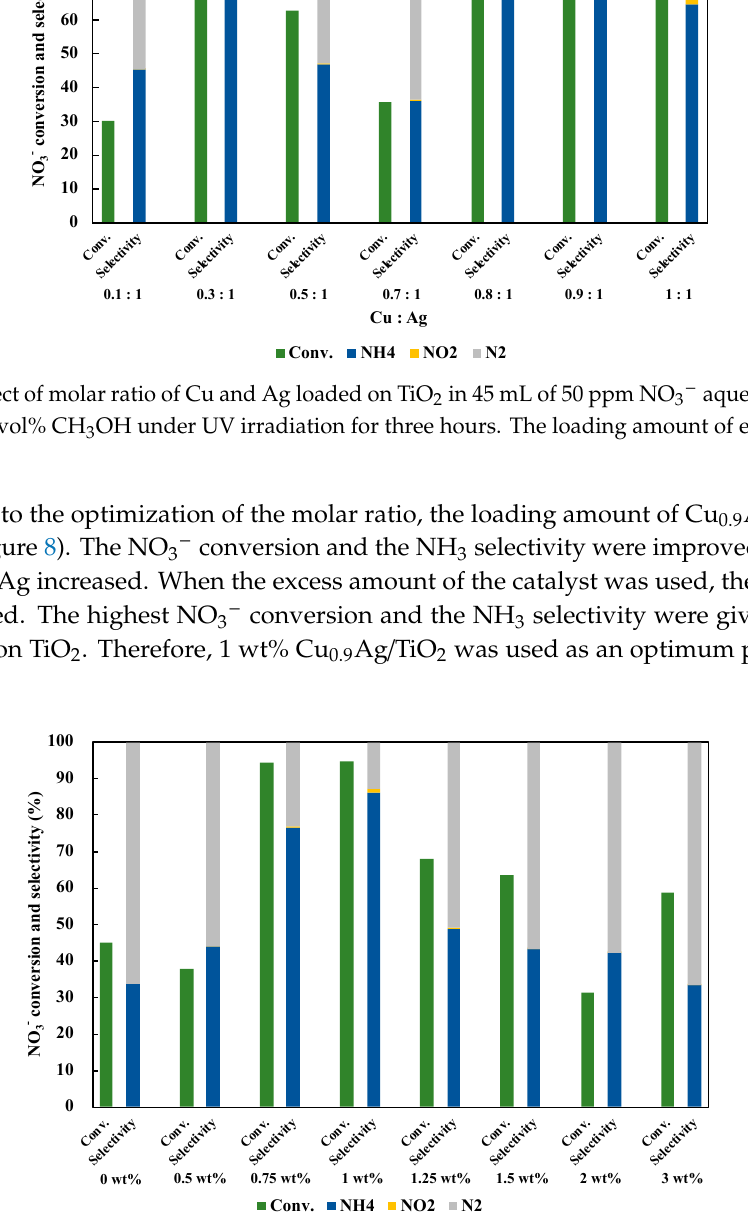
Figure 8. E ff ect of loading amount of Cu 0.9 Ag on TiO 2 in 45 mL of 50 ppm NO 3 − aqueous solution including 10 vol% CH 3 OH under UV irradiation for three hours. The loading amount of each samples was 30 mg.